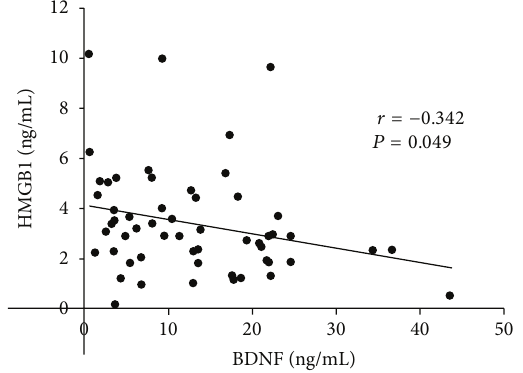
Figure 1: Correlation between serum levels of high-mobility group box-1 (HMGB1) and brain-derived neurotrophic factor (BDNF). There is a significant inverse correlation between serum levels of HMGB1 and BDNF.